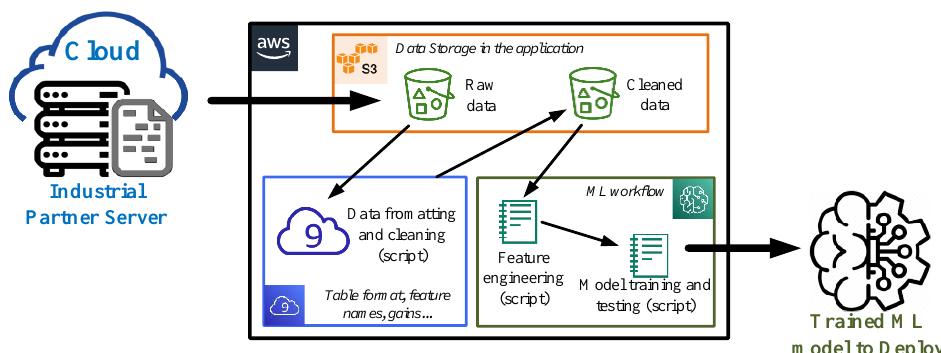
Figure 10. Data-mining architecture in Amazon Web Services platform.